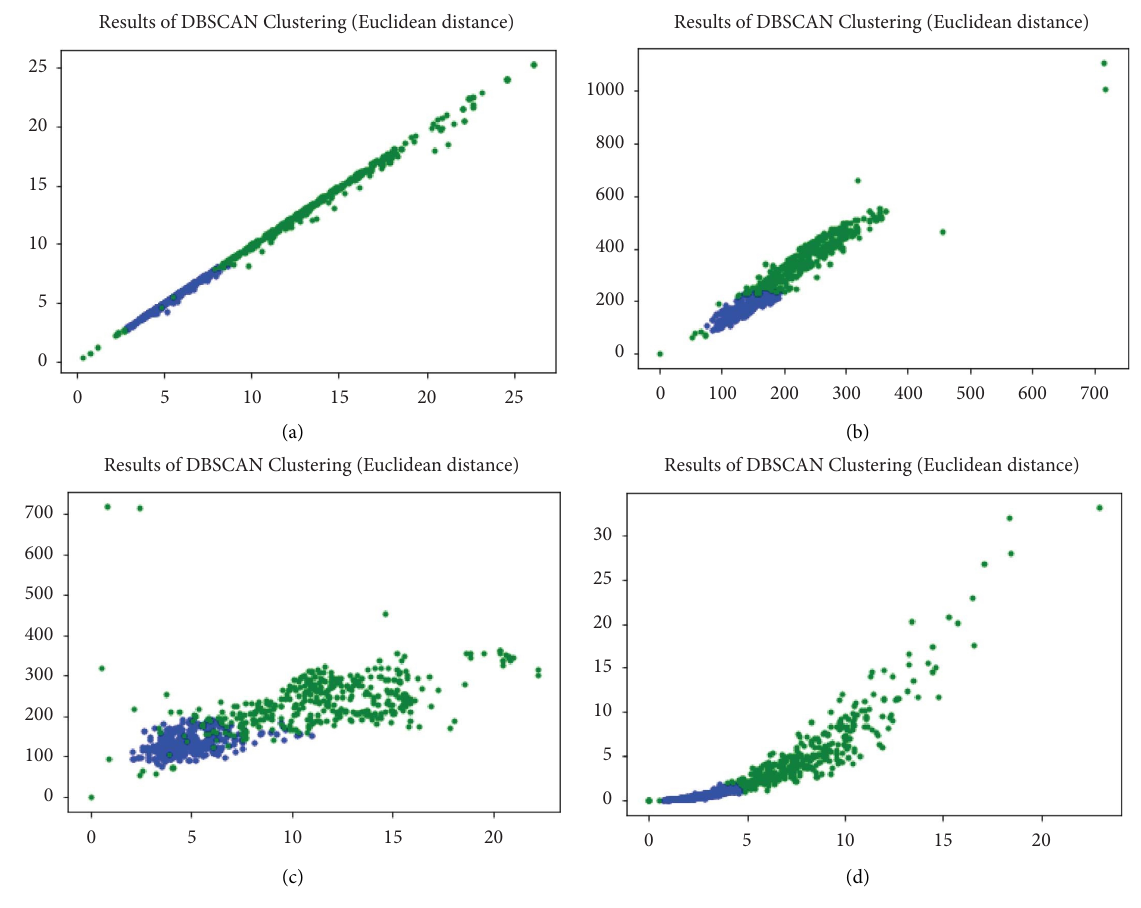
Figure 9: Clustering results of DBSCAN clustering (Euclidean distance). (a) Feature vector f (d) feature vector f h